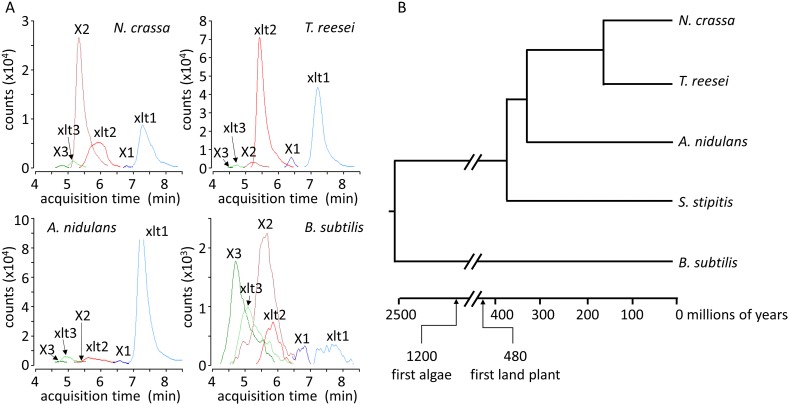
Xylosyl-xylitol and xylosyl-xylosyl-xylitol production by a range of microbes.(A) Xylodextrin-derived carbohydrate levels seen in chromatograms of intracellular metabolites for N. crassa, T. reesei, A. nidulans and B. subtilis grown on xylodextrins. Compounds are abbreviated as follows: X1, xylose; X2, xylobiose; X3, xylotriose; X4, xylotetraose; xlt, xylitol; xlt2, xylosyl-xylitol; xlt3, xylosyl-xylosyl-xylitol. (B) Phylogenetic tree of the organisms shown to produce xylosyl-xylitols during growth on xylodextrins. Ages taken from Wellman et al. (2003); Galagan et al. (2005); Hedges et al. (2006).